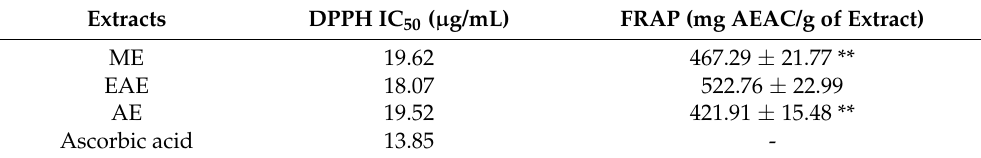
Table 2. The antioxidant activities of the methanol extract (ME) of P. lentiscus L. distilled leaves and its ethyl acetate (EAE) and aqueous (AE) extracts were determined using DPPH radical scavenging and FRAP